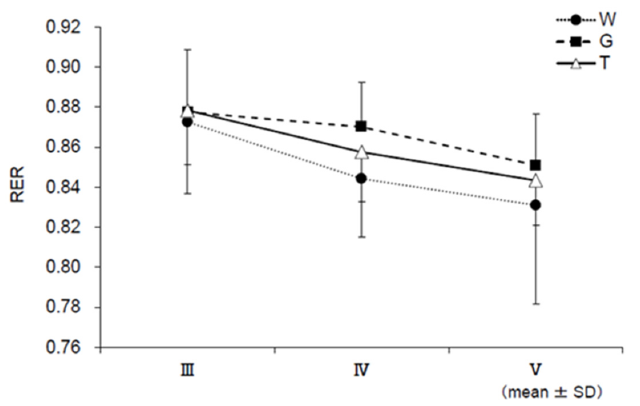
Figure 9. Respiratory exchange ratio (RER) assessments. W—water; G—glucose; T—trehalose.